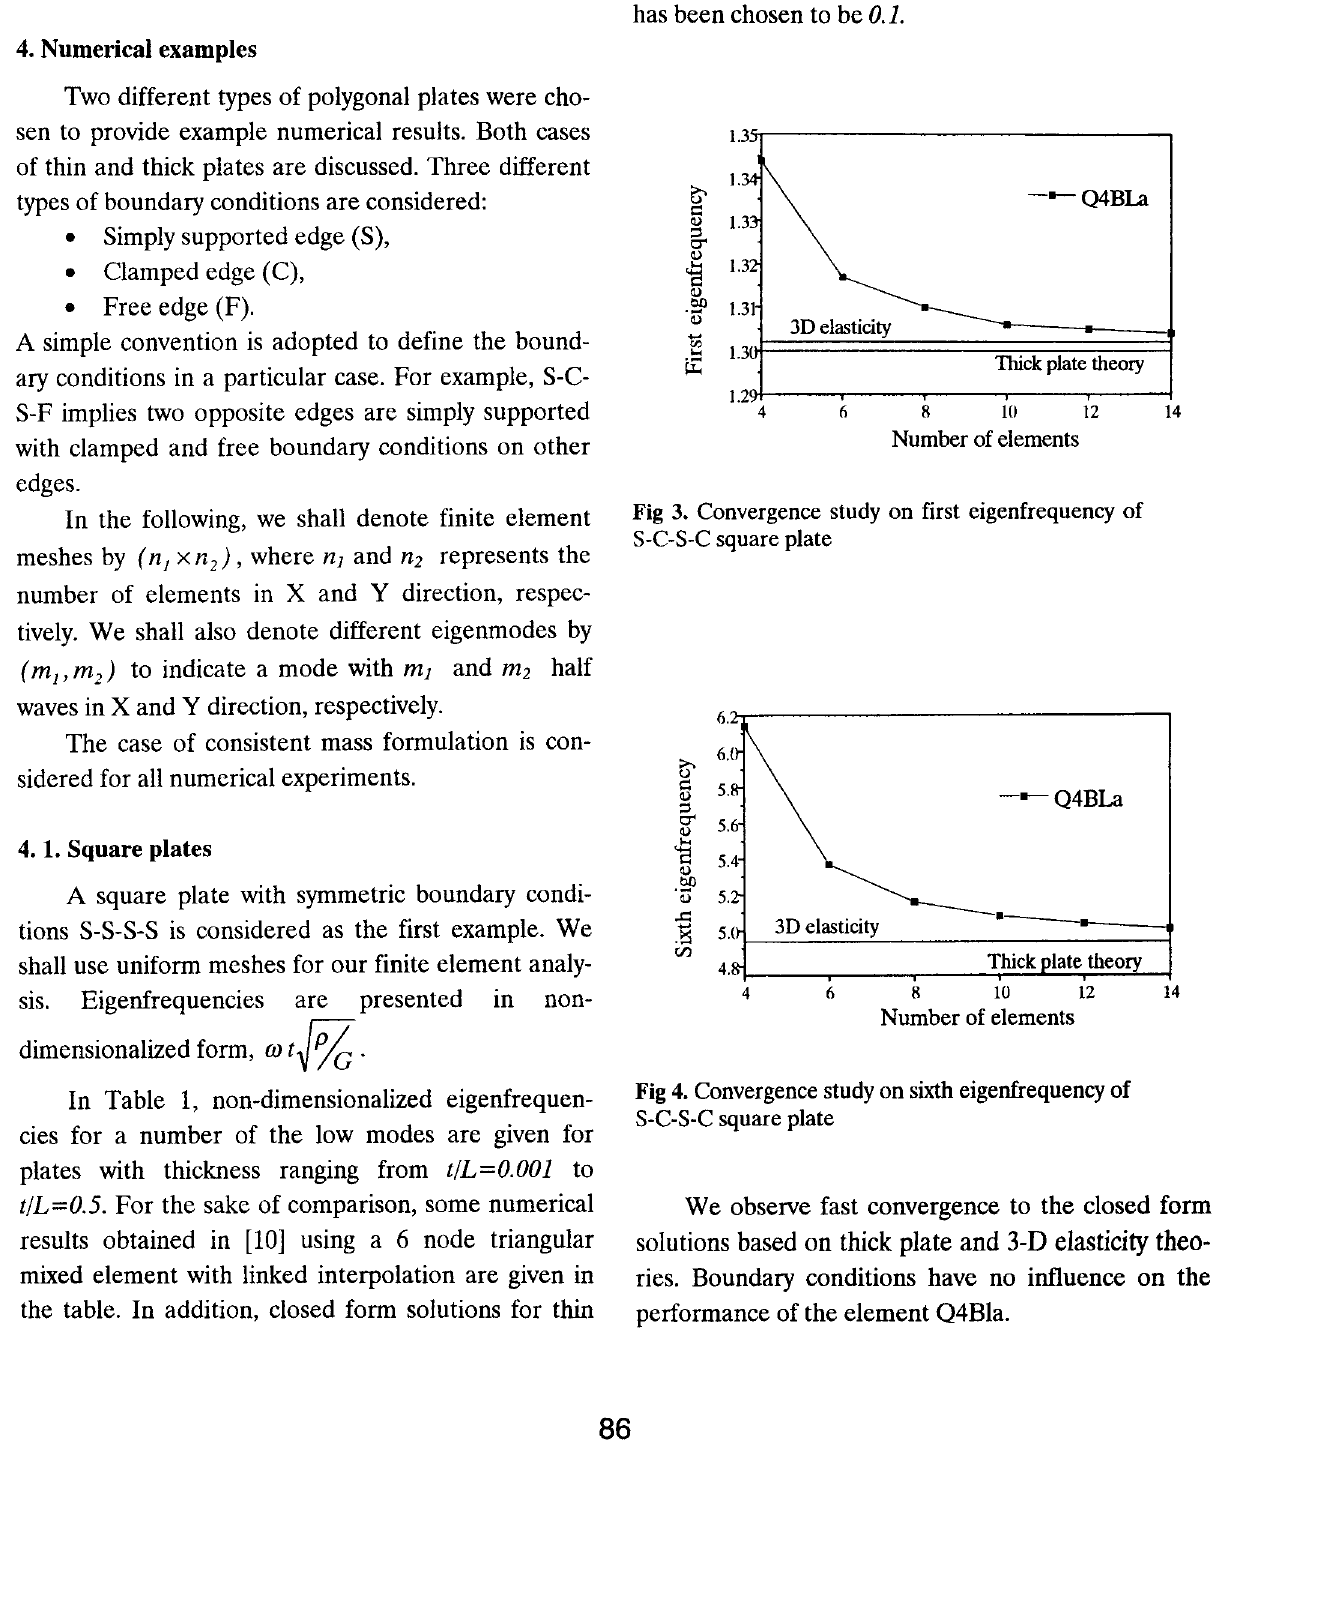
Fig 3. Convergence study on first eigenfrequency of S-C-S-C square plate